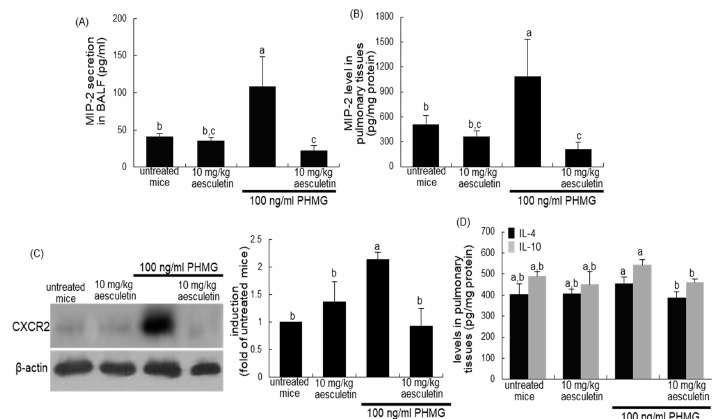
Figure 7. Secretion of MIP-2 in bronchoalveolar lavage fluid (BALF, A ), and levels of MIP-2 ( B ), CXCR2 induction ( C ) and levels of IL-4 and IL-10 ( D ) in pulmonary tissues of polyhexamethylene guanidine (PHMG) inhalation-challenged mice. PHMG-treated mice were orally administrated with 10 mg/kg aesculetin for 4 weeks. The levels of MIP-2, IL-4 and IL-10 in BALF and lungs were measured using ELISA kits ( A , B , D ). Lung tissue extracts were subject to Western blot with a primary antibody against CXCR2 ( C ). β -Actin protein was used as an internal control. The bar graphs (mean ± SEM, n = 3) represent quantitative results of the left bands obtained from a densitometer. Respective values in bar graphs not sharing a letter indicate significant different at p < 0.05. This study investigated whether aesculetin ameliorated the structural alterations in lungs due to increased alveolar EMT and deposition of ECM components. The PHMG inhalation promoted Int. J. Mol. Sci. 2019 , 20 , x FOR PEER REVIEW pulmonary tissue level of N-cadherin, while the E-cadherin level was highly reduced (Figure 8A). In addition, the pulmonary level of ZO-1 was abolished in PHMG-loaded mice (Figure 8B). Oral treatment of PHMG-exposed mice with 10 mg/kg aesculetin reversed the induction of EMT and epithelial junction markers (Figure 8A,B). Collagen fiber deposition was notably observed (blue color) in bronchioles and alveoli of PHMG-exposed mice, as evidenced by Masson’s trichrome staining (Figure 8C). There was marked deposition of collagen fibers around the bronchi and in alveolar tissues of PHMG inhalation-challenged mice. On the contrary, the treatment with 10 mg/kg aesculetin inhibited the collagen fiber deposition, and alleviated subepithelial fibrosis in bronchioles and alveoli (Figure 8C).